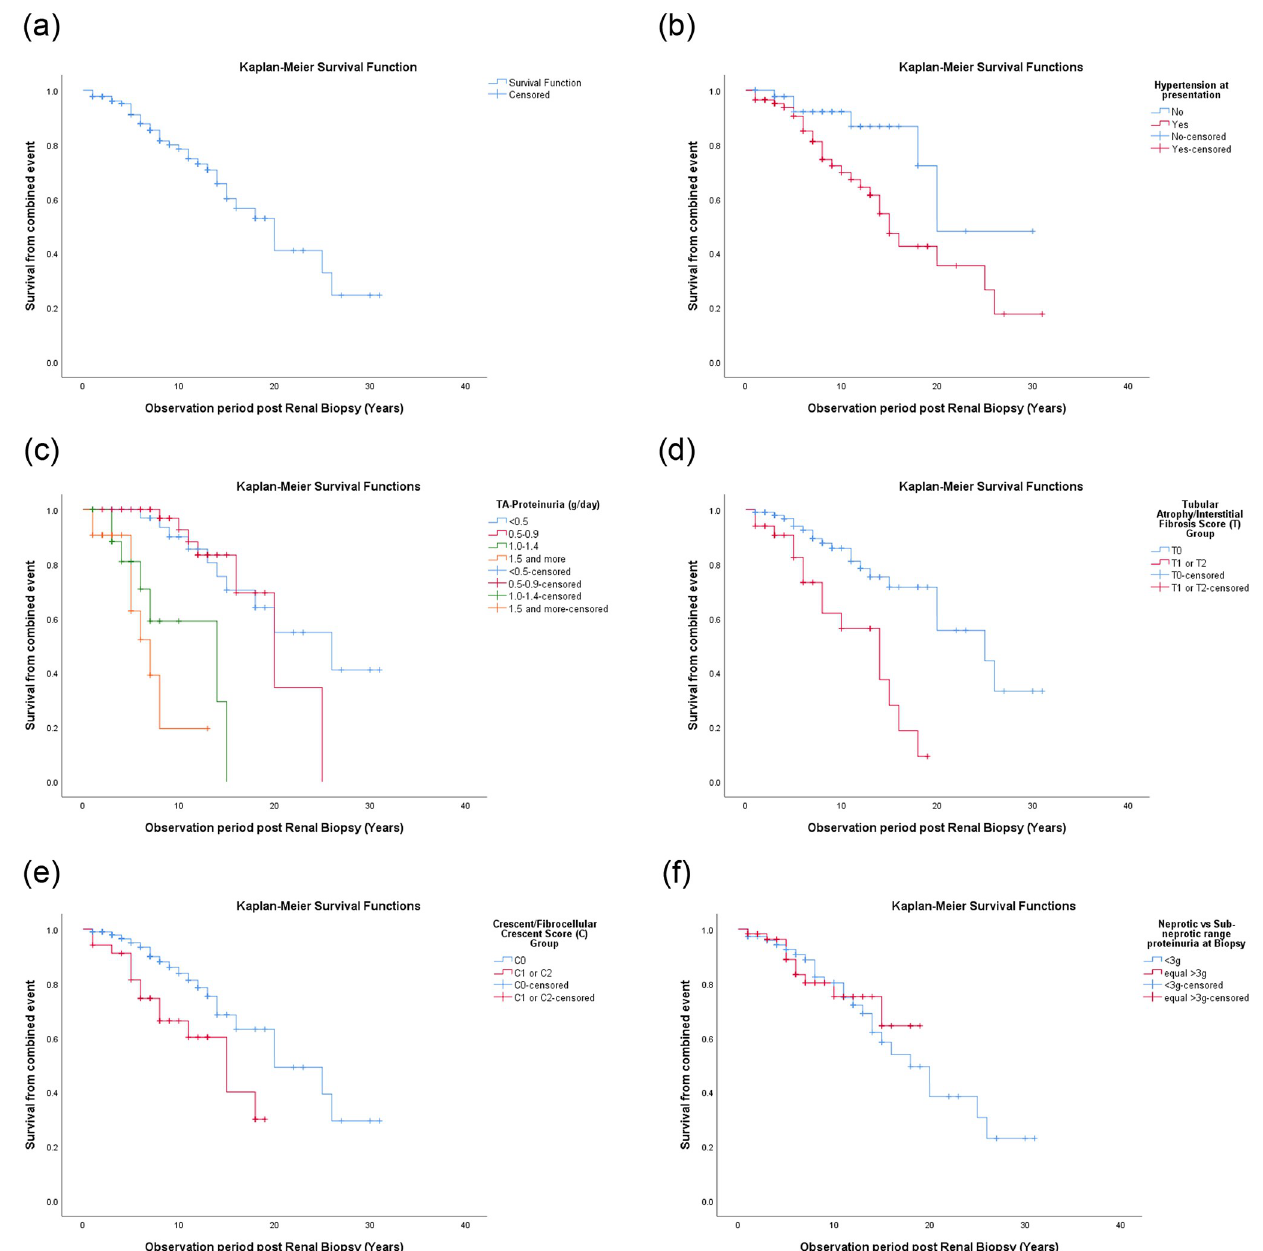
Fig 1. Primary endpoint analysis, i.e., time to first occurrence of combined event of 50% decrease in eGFR or ESRD. (a) Kaplan-Meier curves showing survival from combined event in the entire cohort, categorized by, (b) presence of hypertension at clinical presentation (c) degree of TA-proteinuria, (d) tubular atrophy/interstitial fibrosis (T) score (e) cellular/fibrocellular crescent (C) score and (f) nephrotic range proteinuria (NRP) with sub-nephrotic range proteinuria at biopsy.